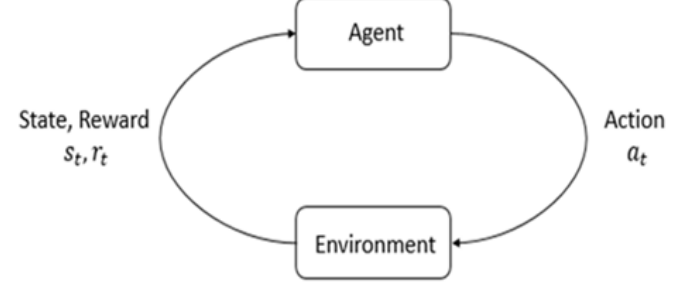
Figure 1. Reinforcement learning